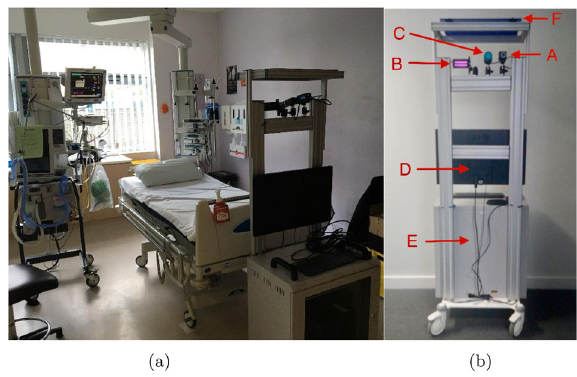
Fig. 6 Monitoring apparatus in the Churchill Hospital ICU in Oxford, United Kingdom. a Patient monitor at the bedside and the non-contact vital-sign monitoring equipment at the end a patient ’ s bed. b Set-up of the trolley containing the non-contact vital-sign monitoring equipment. The components are shown in their respective positions — (A) optical camera; (B) infrared LED source; (C) thermal camera; (D) interface equipment; (E) workstation (in cabinet); (F) privacy blind (folded